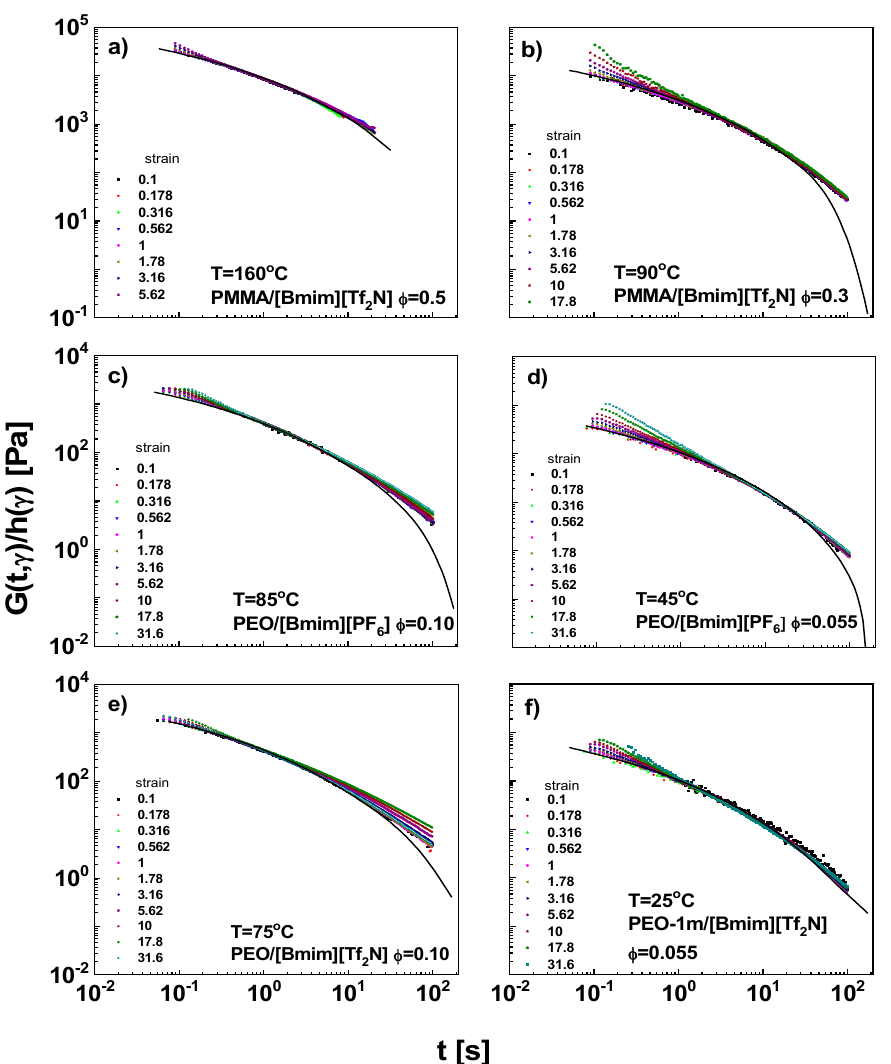
Figure6. Thestressrelaxationmoduliafterverticalshiftingfor( a )PMMA / [Bmim][Tf 2 N], φ = 0.5, 160 ◦ C, Figure 6. The stress relaxation moduli after vertical shifting for ( a ) PMMA/[Bmim][Tf 2 N], ϕ = 0.5, 160 ( b ) PMMA / [Bmim][Tf 2 N], φ = 0.3, 90 ◦ C, ( c ) PEO / [Bmim][PF 6 ], φ = 0.10, 85 ◦ C, ( d ) PEO / [Bmim][PF 6 ], °C, ( b ) PMMA/[Bmim][Tf 2 N], ϕ = 0.3, 90 °C, ( c ) PEO/[Bmim][PF 6 ], ϕ = 0.10, 85 °C, ( d ) PEO/[Bmim][PF 6 ], φ = 0.055, 45 ◦ C, ( e ) PEO / [Bmim][Tf φ = 0.10, 75 ◦ C, and ( f ) PEO / [Bmim][Tf φ = 0.055, 25 ◦ C. 2 N], 2 N], ϕ = 0.055, 45 °C, ( e ) PEO/[Bmim][Tf 2 N], ϕ = 0.10, 75 °C, and ( f ) PEO/[Bmim][Tf 2 N], ϕ = 0.055, 25 °C. Symbols are the same with Figure Symbols are the same with Figure 5.